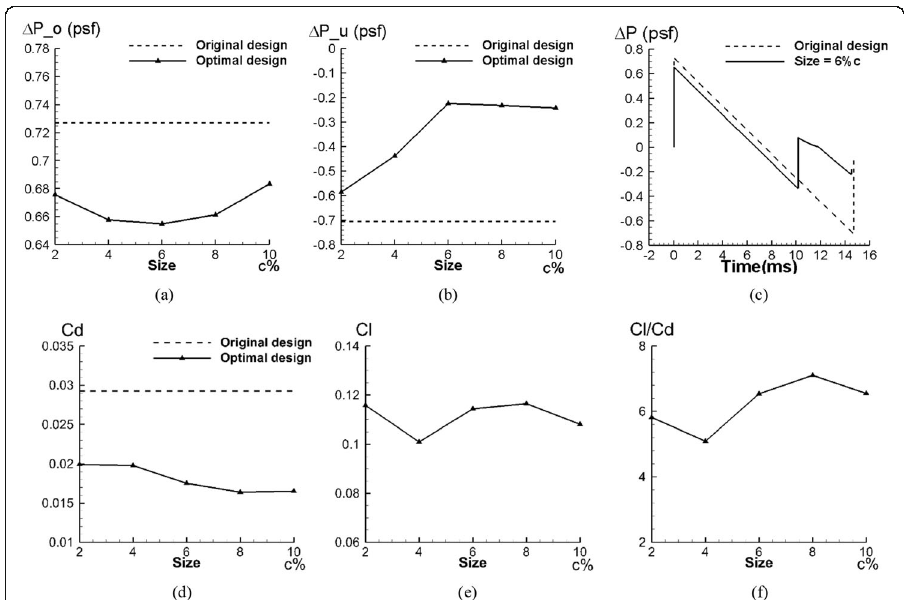
Fig. 16 The ground boom signatures and drag coefficients for the baseline and optimized diamond airfoil with different suction and injection slot sizes. a the maximum overpressure vs the slot size; b the maximum underpressure vs the slot size; c comparison of the ground boom signature at the suction slot size = 6%c; d the drag coefficient vs the slot size; e the lift coefficient vs the slot size; f the lift-drag ratio vs the slot